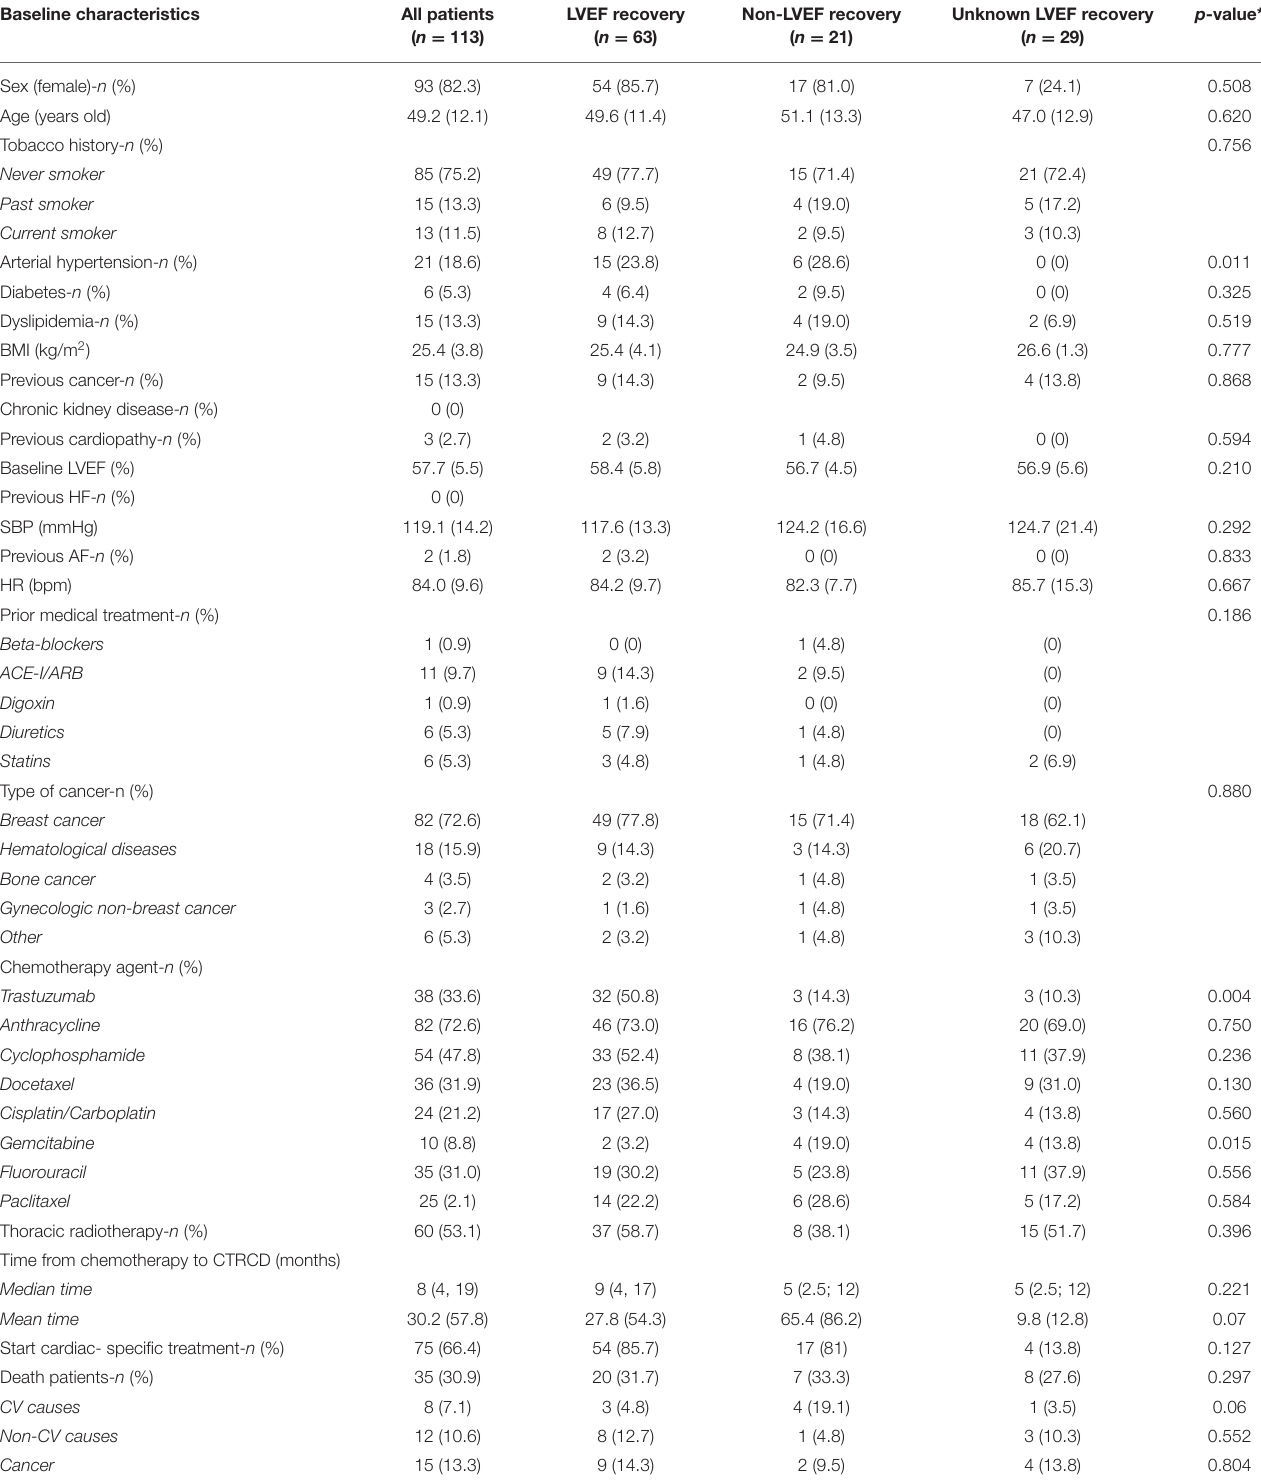
TABLE 1 | The baseline characteristics of patients with cancer therapy-related cardiac dysfunction (CTRCD). Baseline